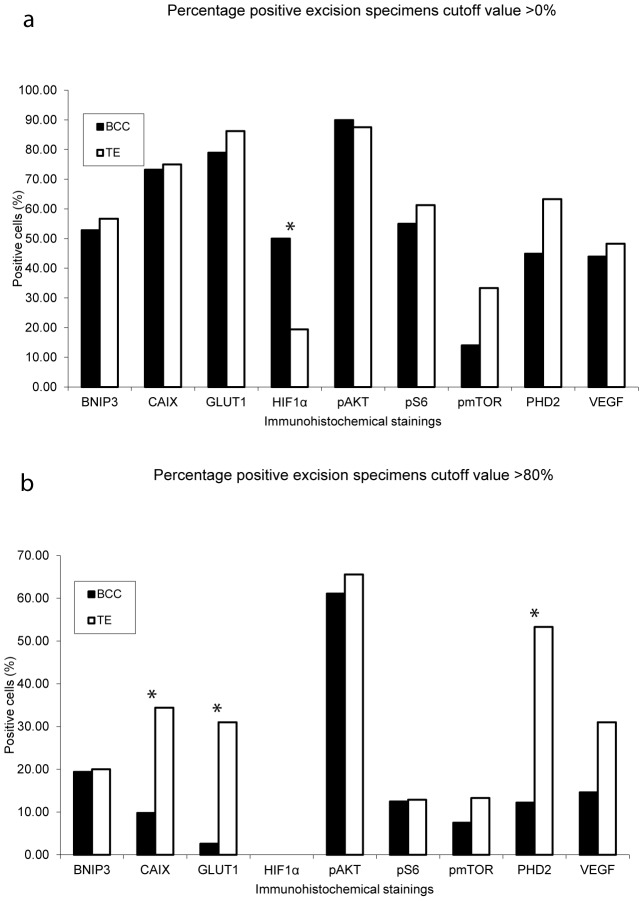
Percentage of positive specimens between basal cell carcinoma and trichoepithelioma.Panel a represents all tissue samples being either positive or negative. In panel b the same results are shown, however here a cut off value of 80% of the tumour cells being positive was used. * (P<0·05), basal cell carcinoma (BCC); trichoepithelioma (TE).